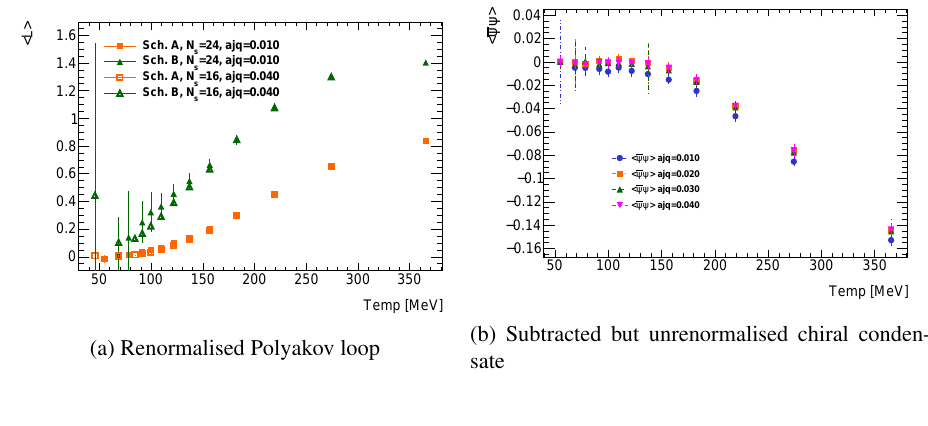
Figure 5: Bosonic